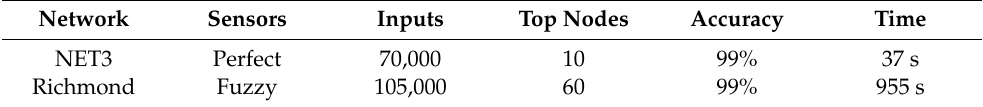
Table 3. Trained RF classifier characteristics.